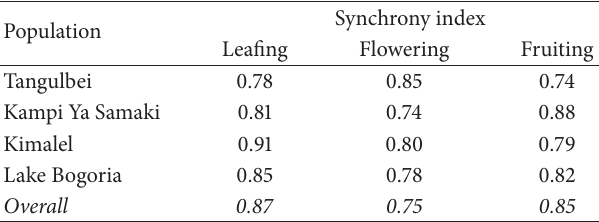
Table 3: Synchrony indices for phenological events of S. senegal within Lake Baringo woodland